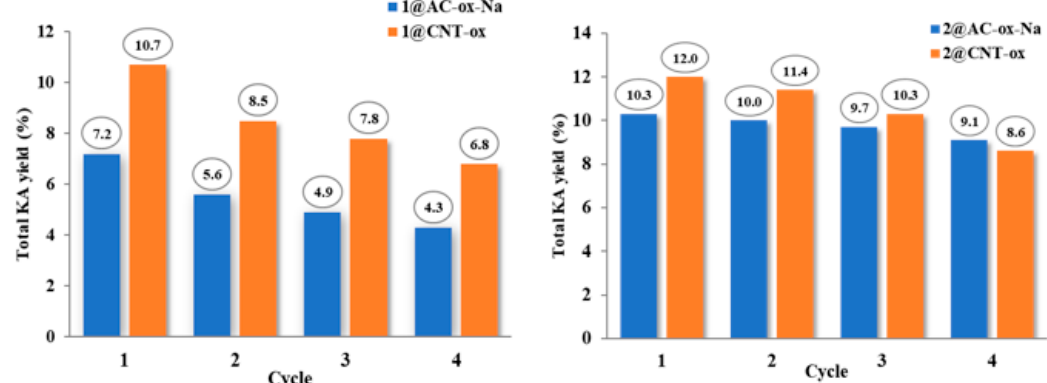
Figure 6. Recyclability of 1 @AC-ox-Na and 1 @CNT-ox ( left ) and of 2 @AC-ox-Na and 2 @CNT-ox ( right ) catalysts in the oxidation of cyclohexane to yield KA